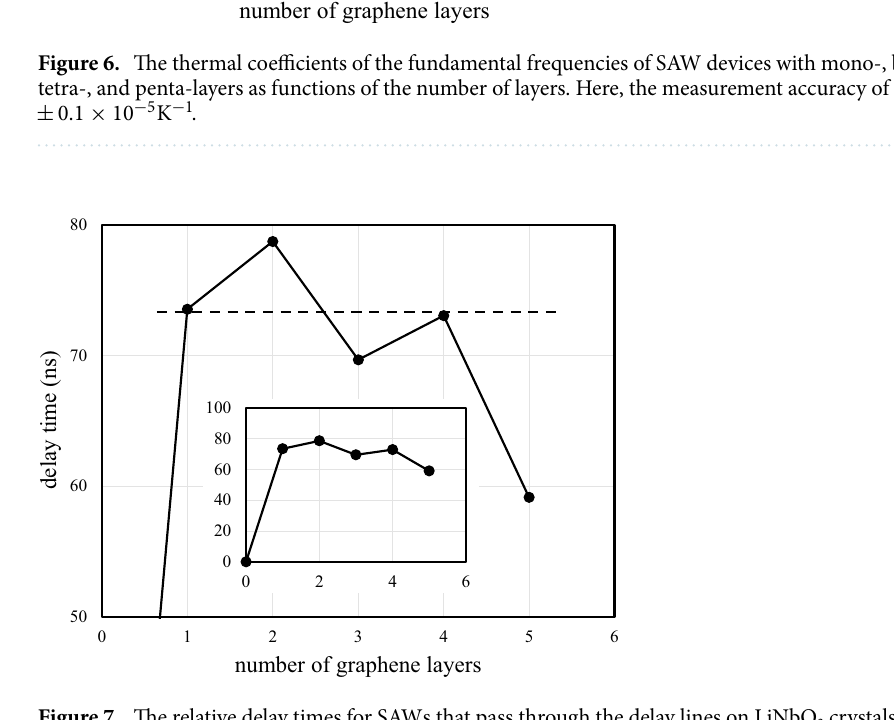
Figure 7. The relative delay times for SAWs that pass through the delay lines on LiNbO 3 crystals with mono-, bi-, tri-, tetra-, and penta-graphene layers as functions of the number of graphene layers. Here, the measurement accuracy of the delay time is ± 1